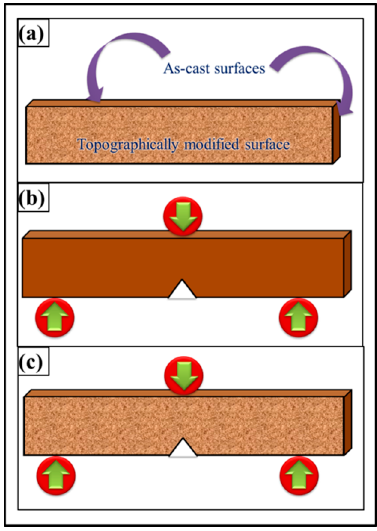
Figure 18. ( a ) Topographically modified front and back surfaces. The sides were not treated with abrasive papers; ( b ) As-cast; ( c ) topographically modified K 1C specimen under bending load.